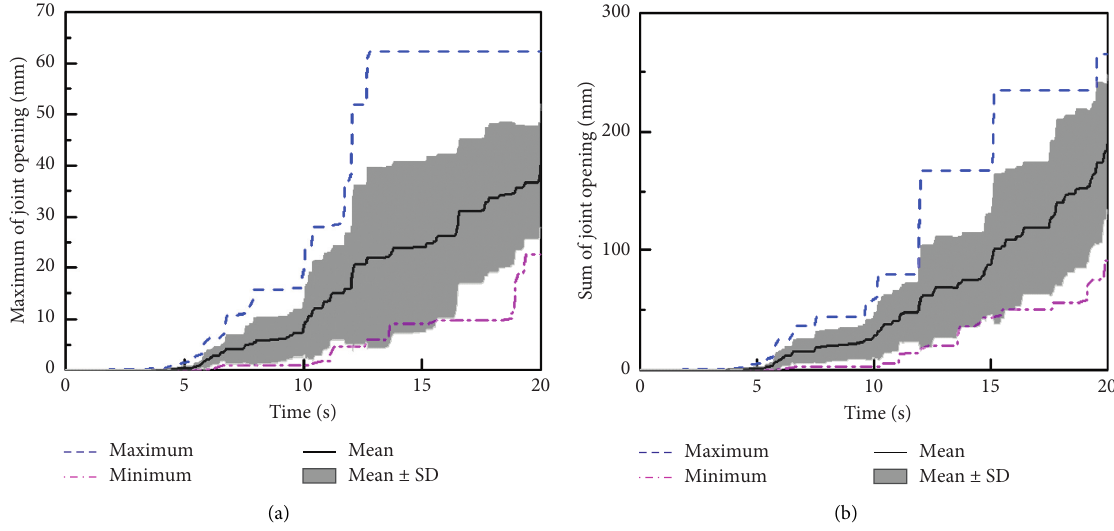
Figure 16: Fragility joint opening indices under different earthquake intensities: (a) MJO; (b) SJO.